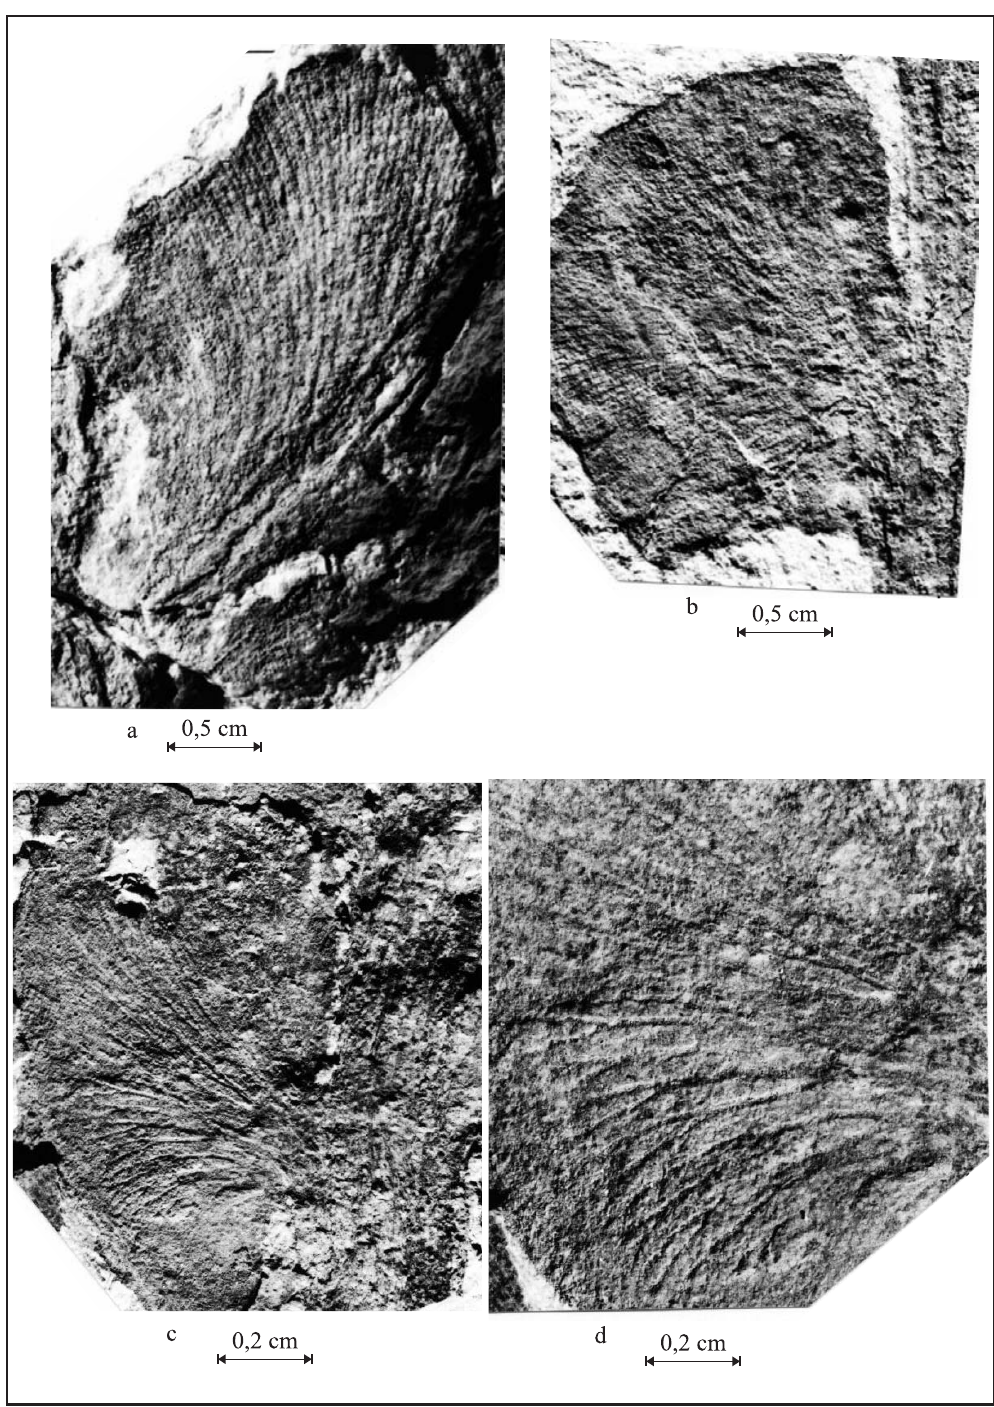
Fig. 6 – Details of pines of Botrychiopsis valida from Quitéria (a) detail of an apical pine with venation – PbU 0061; (b) detail of a basal pine – PbU 0062; (c) detail of a pine with venation – PbU 0233; (d) detail of venation of a basal pine, showing venation dichotomy – PbU